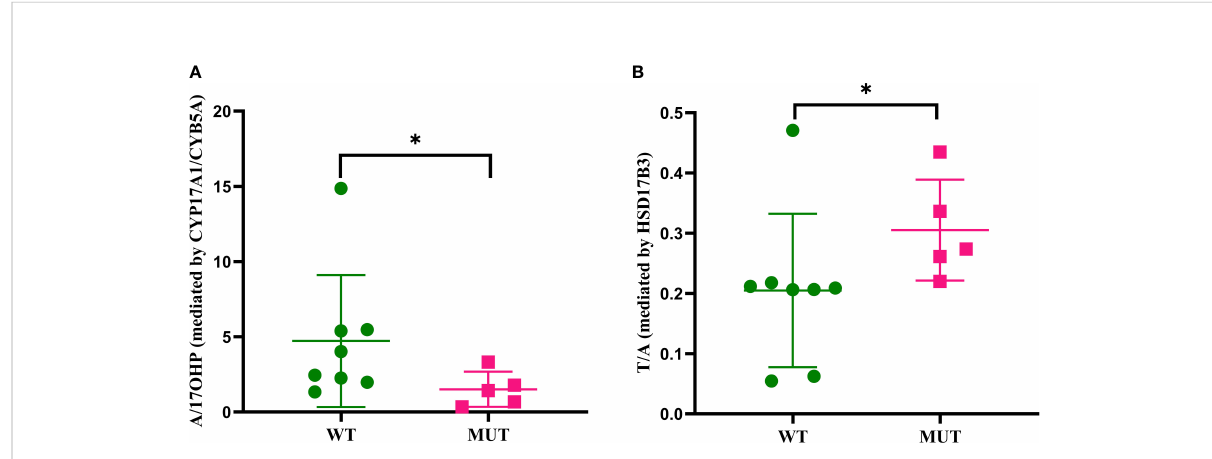
FIGURE 5 Conversion ratio analysis of peripheral steroids based on ARMC5 status. Only signi fi cant conversion ratios are displayed. (A) Comparison of A/ 17OHP between wild-type ARMC5 patients and mutant ARMC5 patients. (B) Comparison of T/A between wild-type ARMC5 patients and mutant ARMC5 patients. A, androstenedione; 17OHP, 17-hydroxyprogesterone; T, testosterone. WT, wild-type ARMC 5 patients; MUT, mutant ARMC5 patients. * p <0.05